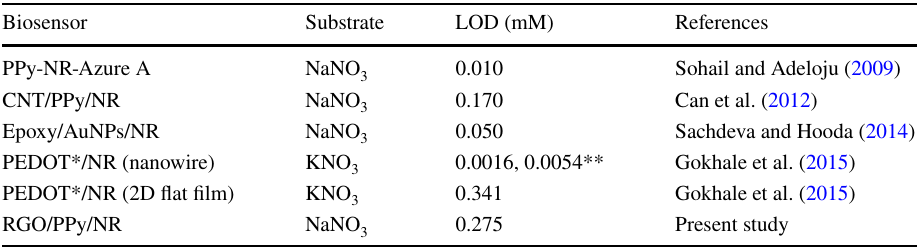
Table 1 Limit of detection (LOD) of different types of